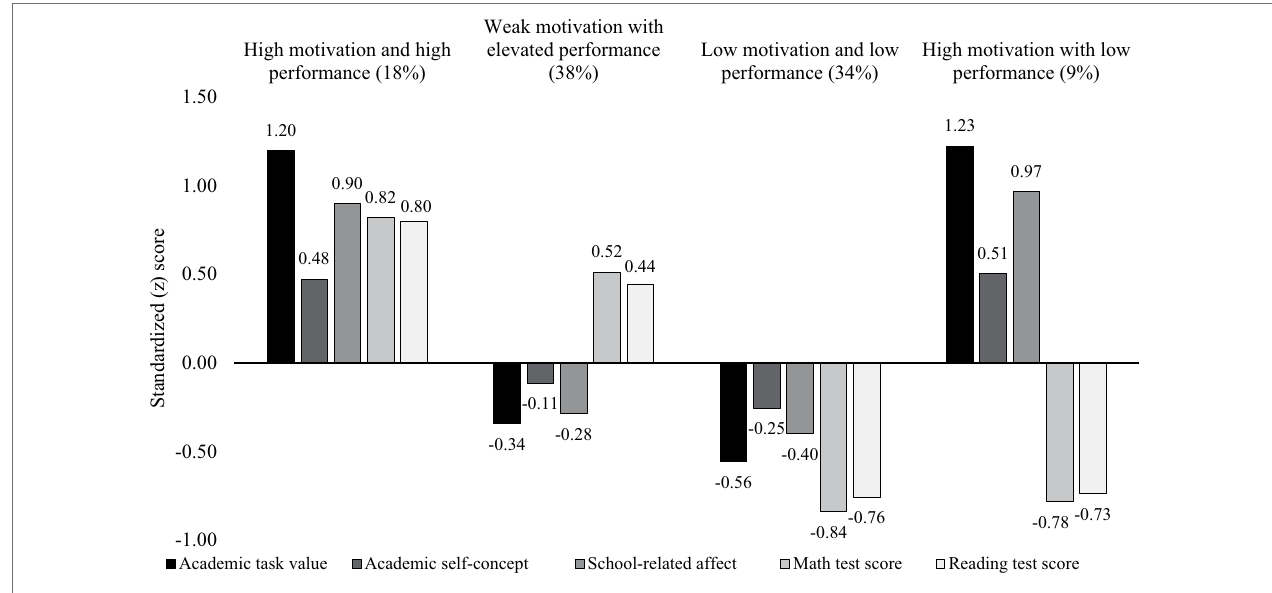
FIGURE 1 | Mean levels of school performance and the three aspects of motivation across the four